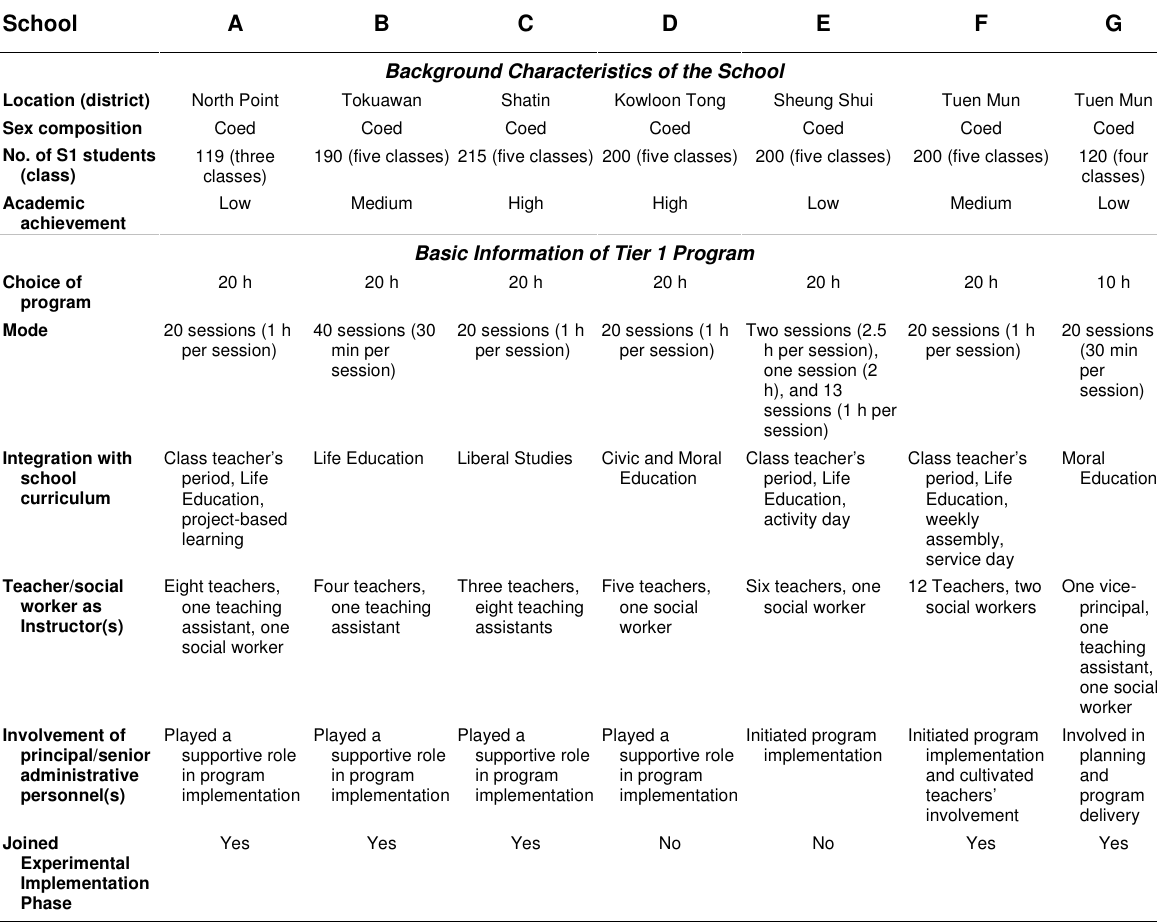
Summary on the Characteristics of Schools that Joined the Case